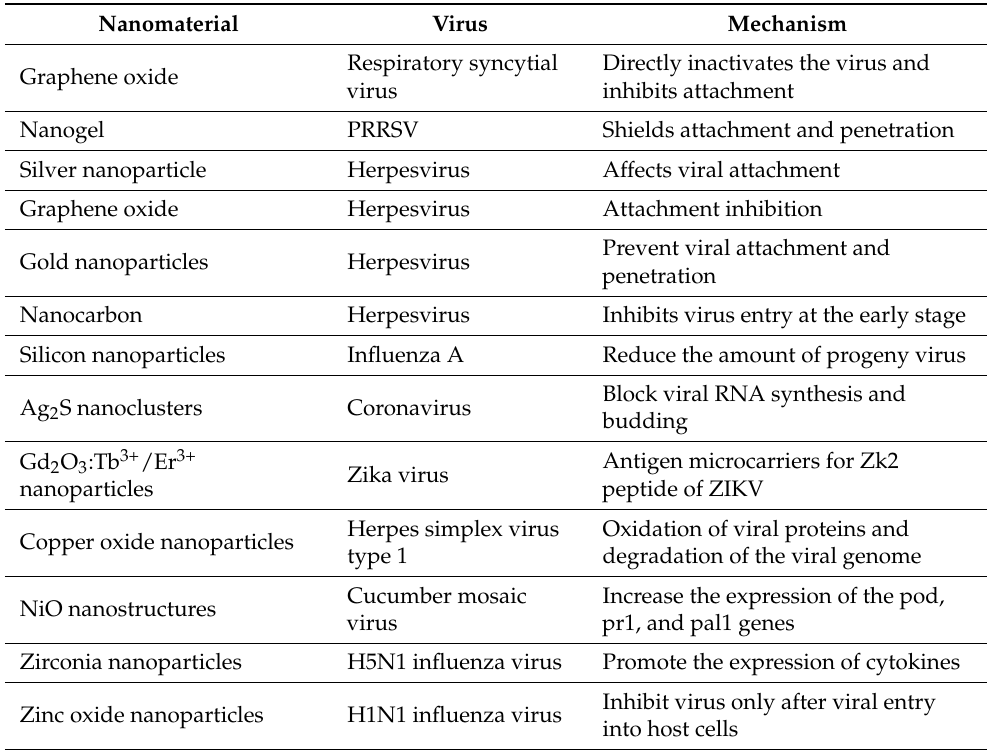
Figure 4. Antiviral mechanisms of engineered nanoparticles. Adapted with permission from ref. [34], published by MDPI, 2020. Table 1. Antiviral activity mechanisms of various nanoparticles. Adapted with permission from ref. [66], published by Elsevier, 2020.